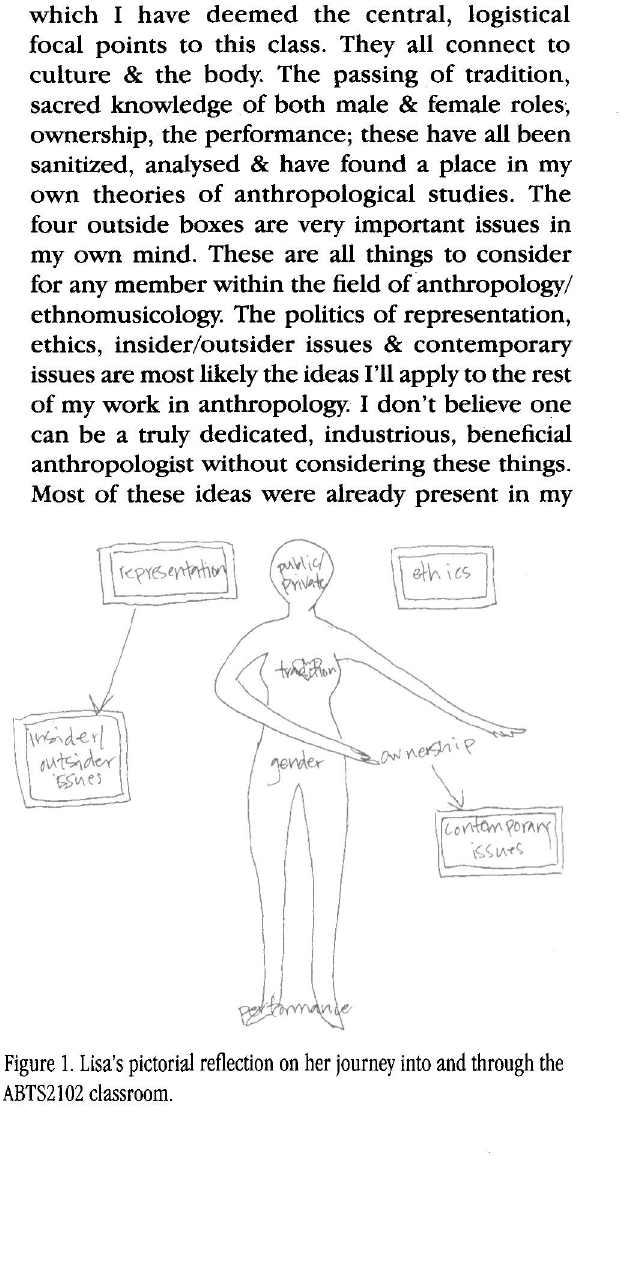
Figure 1. Lisa's pictorial reflection on her journey into and through the ABTS2102